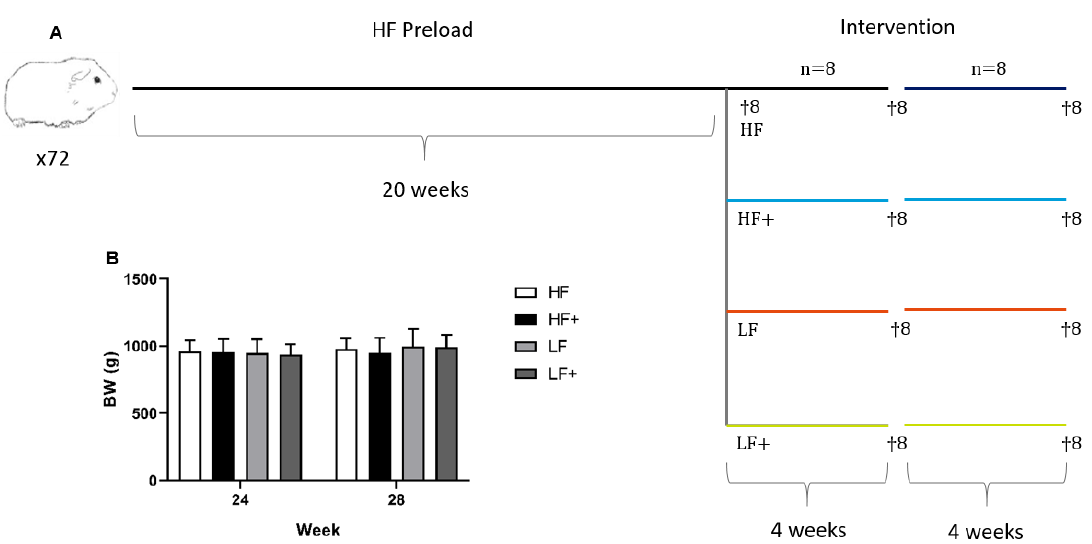
Figure 1. Study overview and body weights of animals. ( A ) Seventy-two guinea pigs were preloaded on a high-fat diet for 20 weeks. Prior to intervention, eight animals were randomly selected for euthanasia, serving as baseline values. The remaining guinea pigs were weight stratified into the following groups ( n = 16): HF, continuing on the high-fat diet (20%, 0.35% cholesterol, and 15% sucrose); HF + , receiving high-fat diet with atorvastatin and vitamin E (20 mg / kg feed atorvastatin and 375 mg / kg feed all-rac vitamin E, for a guinea pig corresponding to a daily intake of 1 mg / kg atorvastatin and 800 IU vitamin E); LF, receiving a standard guinea pig chow diet (4% fat, 0% cholesterol, and 0% sucrose); LF + , receiving a standard guinea pig chow diet with atorvastatin and vitamin E (20 mg / kg feed atorvastatin and 375 mg / kg feed vitamin E). After four weeks of intervention, eight randomly chosen guinea pigs, from each group, were euthanized, leaving the remaining eight animals for another four weeks of intervention before termination. ( B ) No di ff erences were recorded in body weight (BW) through the